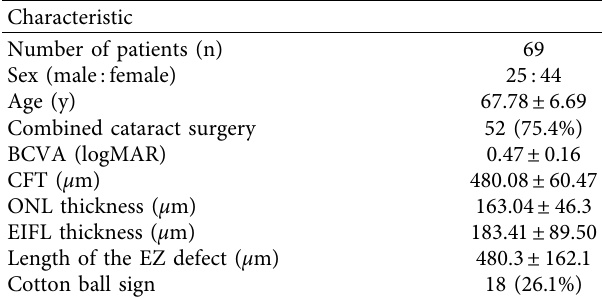
Table 1: Baseline